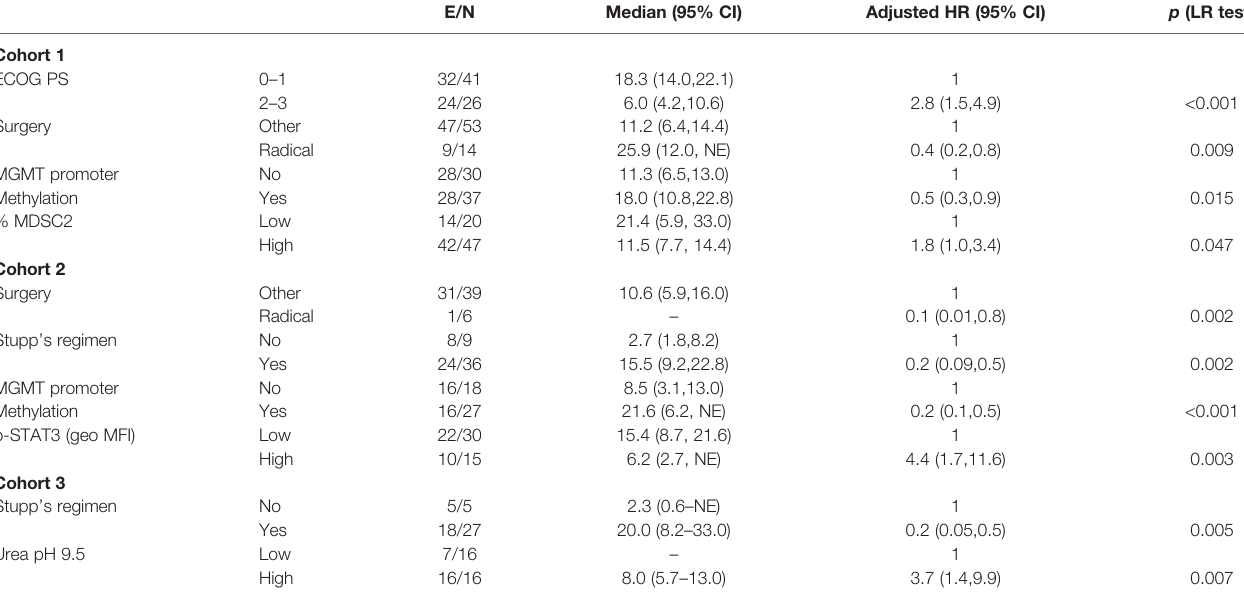
TABLE 4 | Factors for grade IV glioma patients ’ survival (multivariate analysis with Cox proportional hazards